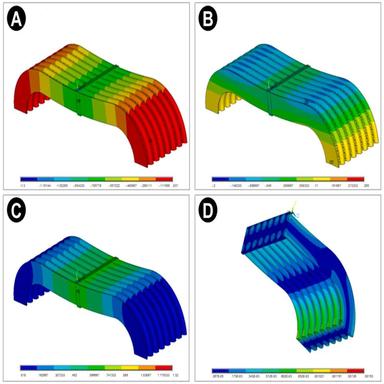
Maps obtained for the pressure applied on the upper surface: (A) displacement in Y direction , (B) displacement in Z direction (C) accidental displacement and (D) reduced stresses.